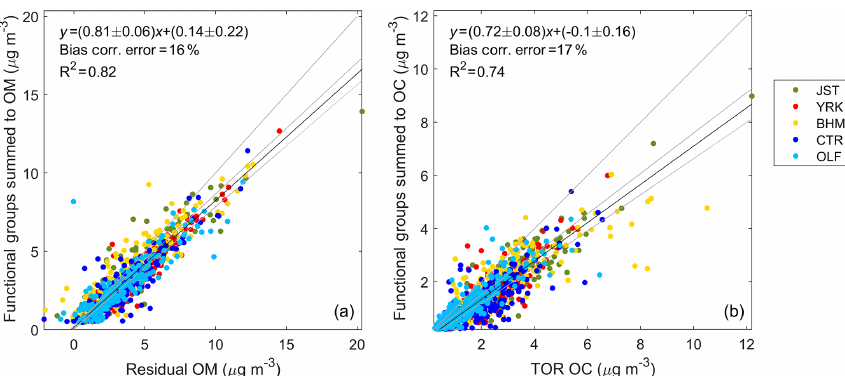
Figure 3. Scatter plots of predicted functional group OM and OC concentrations versus reference measurement concentrations. (a) Ref- erence values are residual OM concentrations; FT-IR OM MDL = 0 . 38µgm − 3 . (b) Reference values are TOR OC concentrations; FT-IR OC MDL = 0 . 19µgm − 3 . Site abbreviations: JST = Jefferson Street, Atlanta, GA; YRK = Yorkville, GA; BHM = Birmingham, AL; CTR = Centreville, AL; OLF = an outlying landing field near Pensacola, FL.